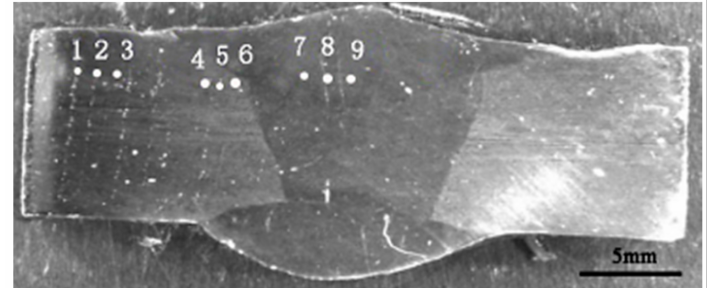
Figure 1. Hardness point location.